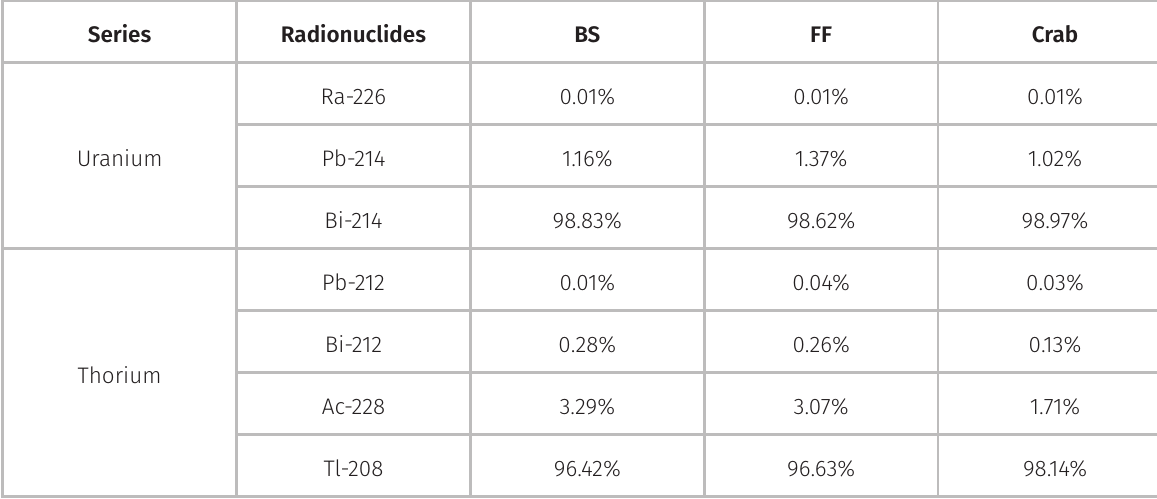
due to each radionuclide. R